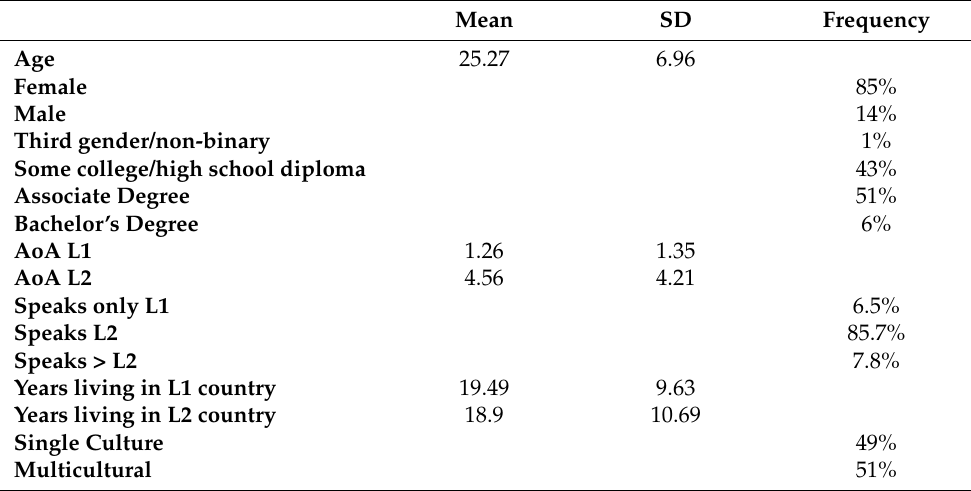
Table 1. Sample demographic details ( N =